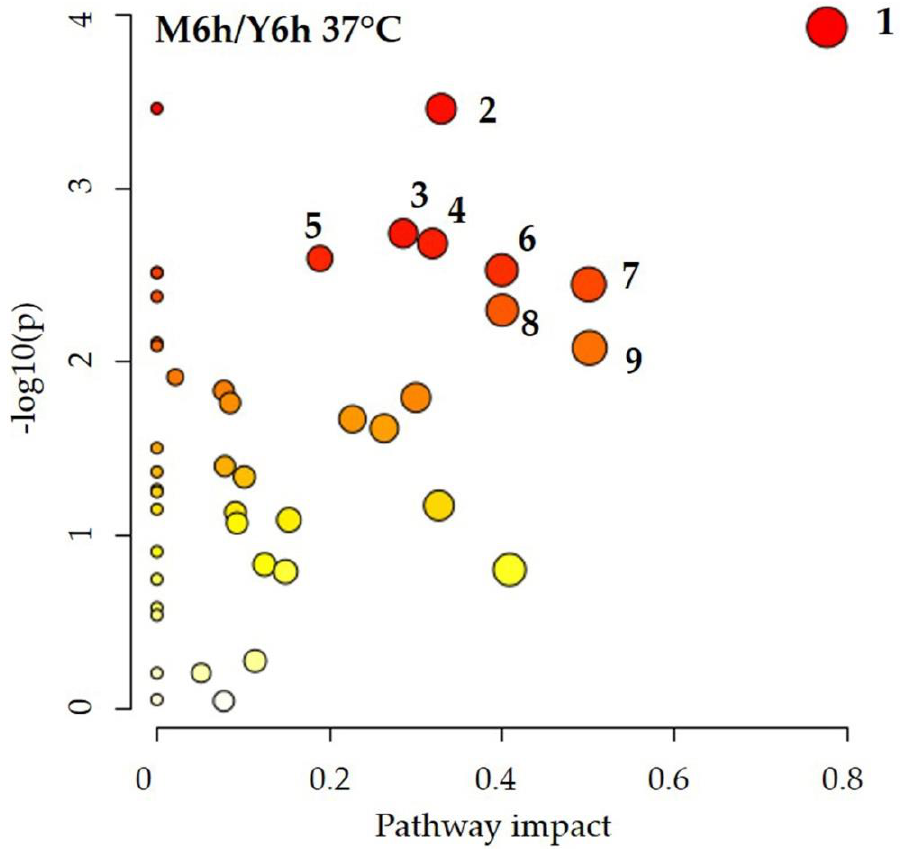
Figure 7. Pathway analysis showing the significantly enriched pathways that arose from comparing the metabolomic datasets obtained in M199 and YPD at 37 °C. Matched pathways are displayed as circles. The color of each circle is based on p values (a darker color indicates more significant differences in metabolite concentrations of a specific pathway), whereas the size of the circle corresponds to the pathway impact score. The most significantly impacted pathways ( p < 0.01), with high statistical significance scores, are: (1) alanine, aspartate, and glutamate metabolism; (2) arginine and proline metabolism; (3) glycerolipid metabolism; (4) arginine biosynthesis; (5) glyoxylate and dicarboxylate metabolism; (6) nicotinate and nicotinamide metabolism; (7) β -alanine metabolism; (8) butanoate metabolism; (9) glutathione metabolism. p values denote enrichment of the entire pathway by Fisher’s exact test.